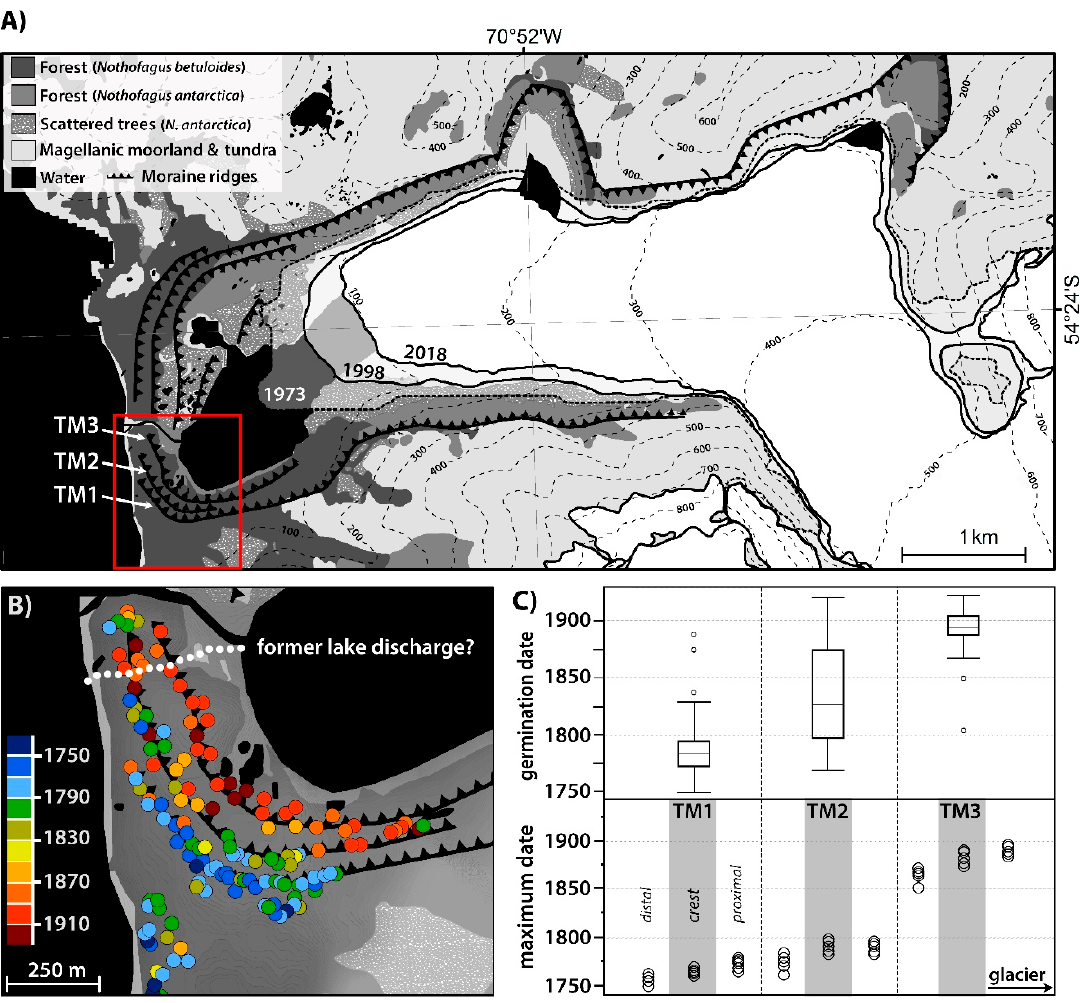
Figure 6. ( A ) Landforms and vegetation distribution in the glacial forefield of Schiaparelli Glacier. ( B ) Germination dates of the individual trees sampled on the terminal moraine system. Different colors display germination periods. (C ) Overall age structures of the TM1–TM3 moraine systems (upper panel) and germination dates of the five oldest trees with respect to the geolocation on the moraine slopes (lower panel).